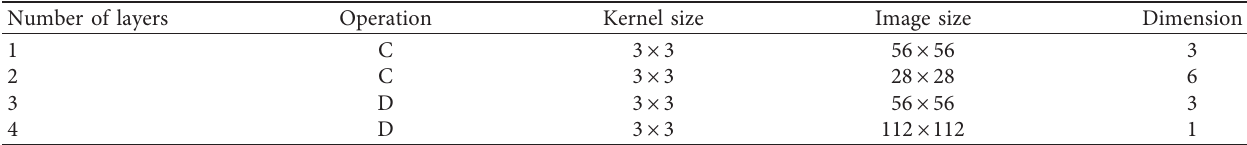
Table 1: Parameters of autoencoder network